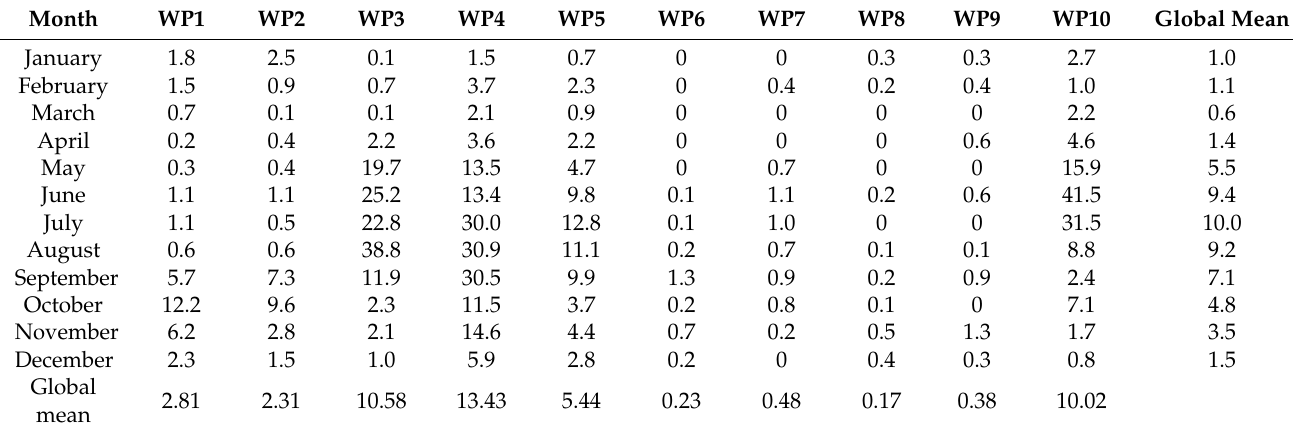
Table 4. Mean monthly number (observation period 2011–2020) of recorded positive lightning strikes per wind park and global mean per wind park and month.